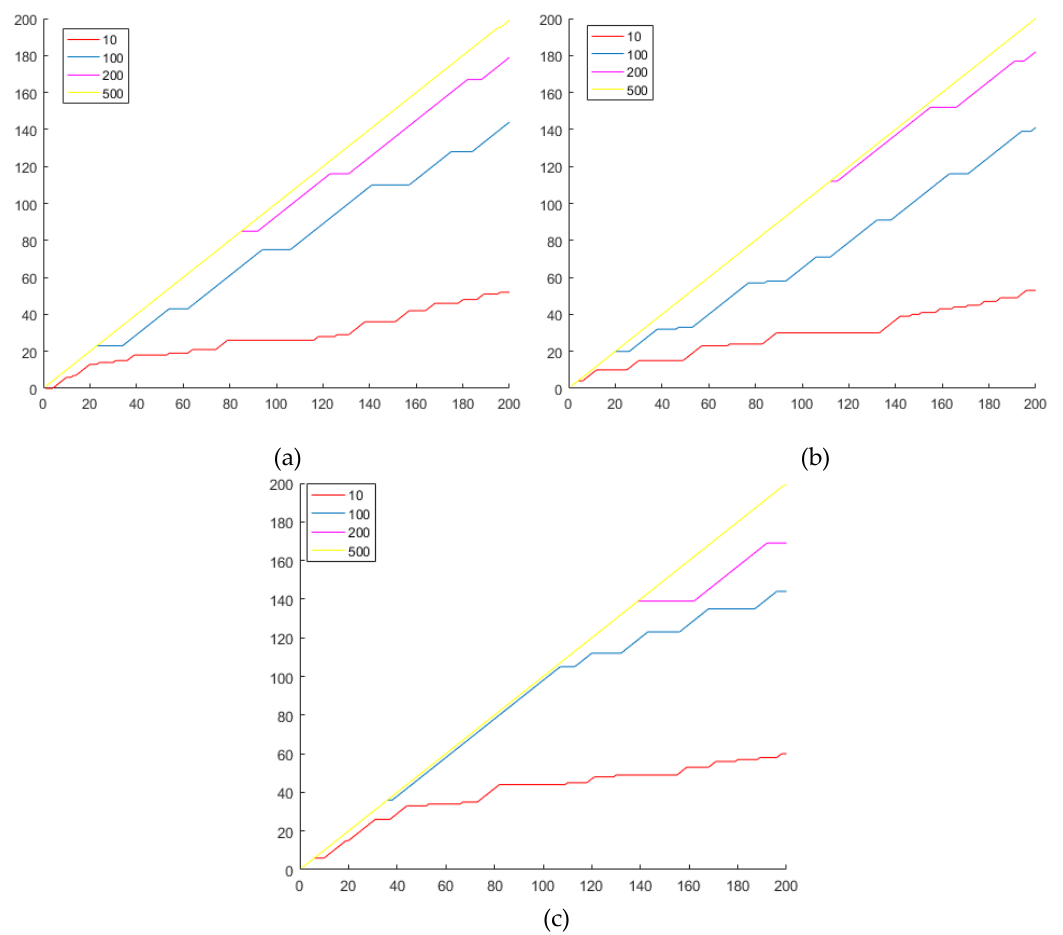
Figure 26. The growth trend of 200 test irises, ( a ) 4.0, ( b ) 6.0, ( c ) 7.0.